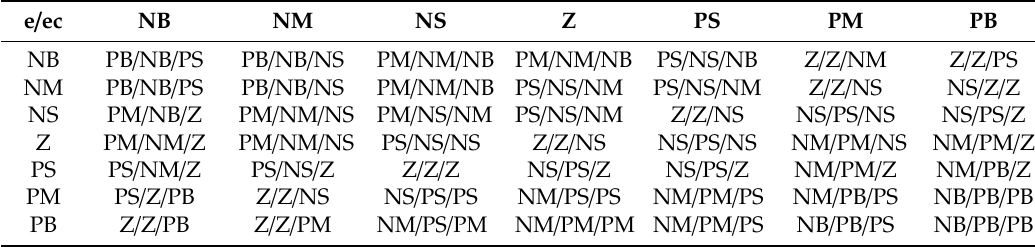
Figure 13. ( a ) membership curves of e, ec, k d ; ( b ) membership curves of k p and k i . Table 2. Control rules of k p , k i , and k d .